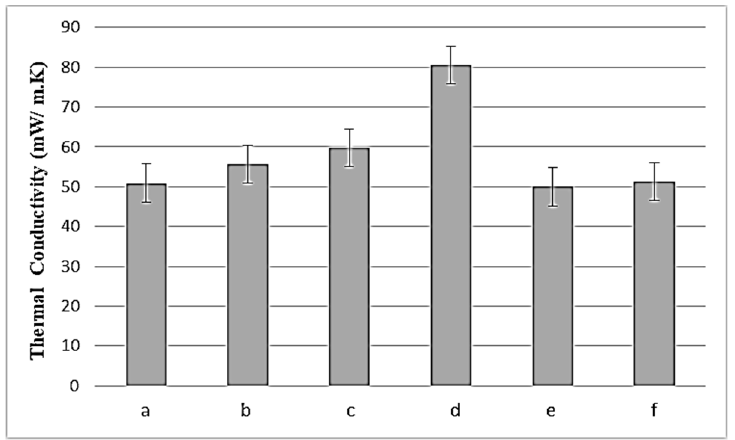
Figure 4. Thermal conductivity values for each specimen versus % content in CaCl 2 based on one-way ANONA ( p < 0.01). a: untreated; b: 10 wt % CaCl 2 ; c: 25 wt % CaCl 2 ; d: 50 wt % CaCl 2 ; e: 5 washes for b samples; f: 10 washes for b samples. The data are represented as mean ± SD.